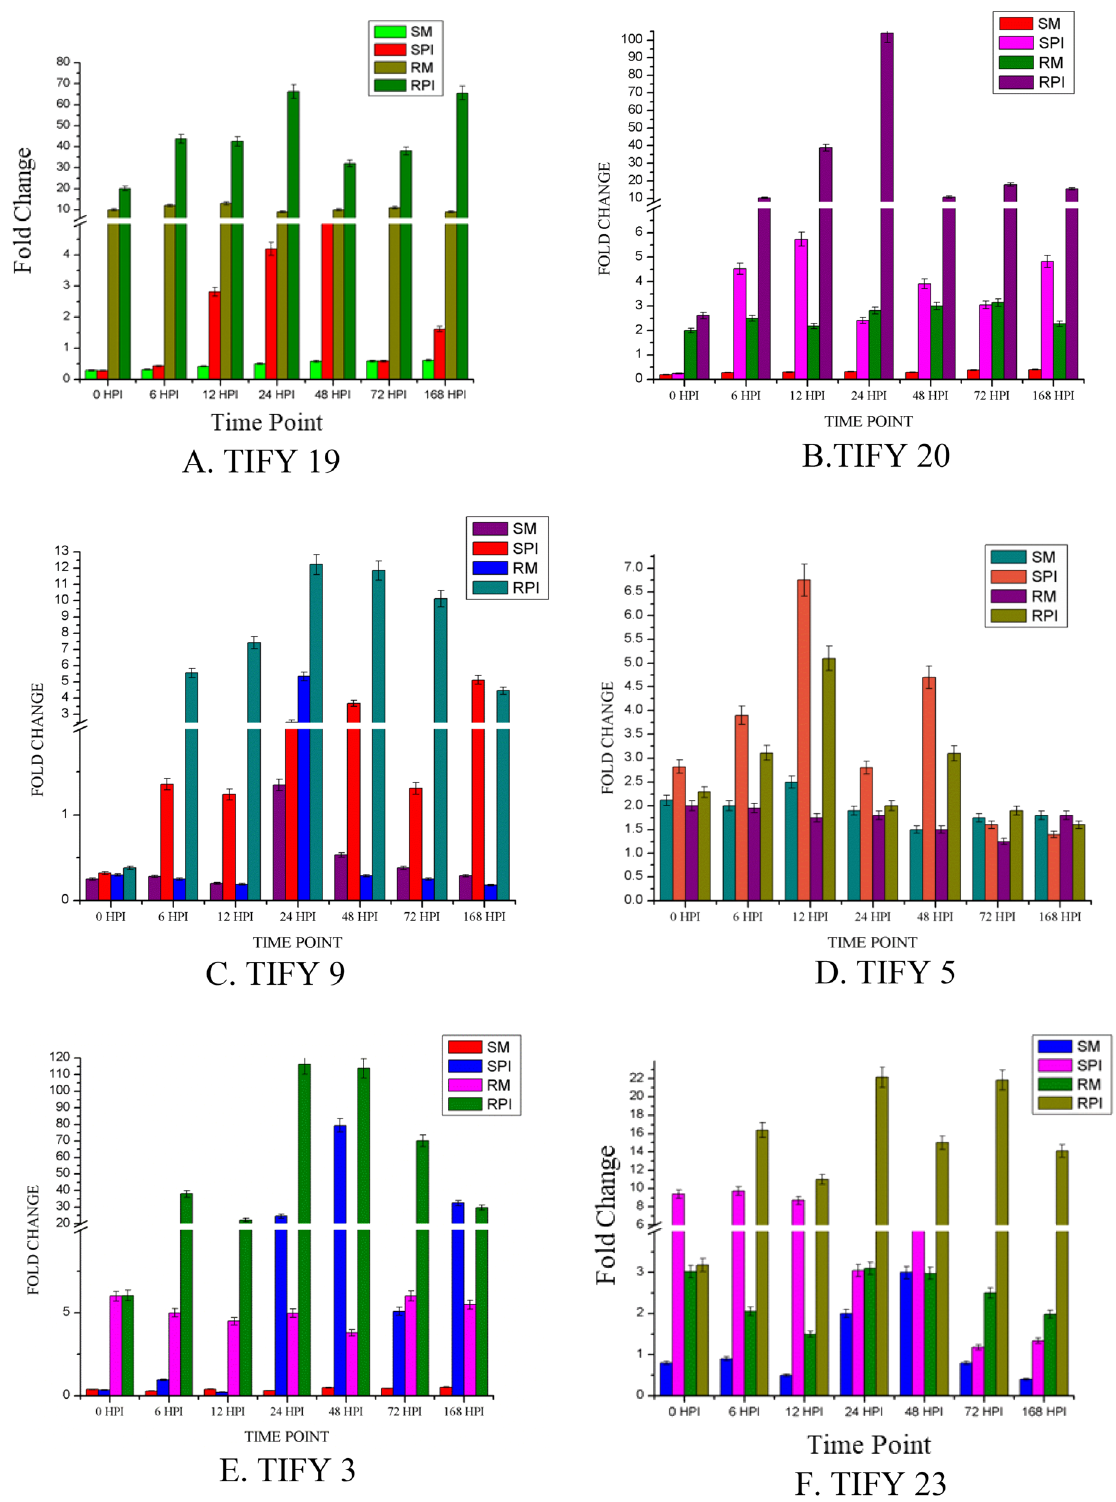
Figure 8. Spatio-temporal expression of TaTIFY family genes in response to biotic stress. Expression profiles of susceptible (HD2329) and resistant (HD2329 + Lr28 ) wheat plants in response to leaf rust infection compared with mock inoculated controls. Relative expression is expressed as fold changes relative to mock inoculated controls. (S-M, susceptible mock; S-PI, susceptible pathogen inoculated; R-M, resistant mock; R-PI, resistant pathogen